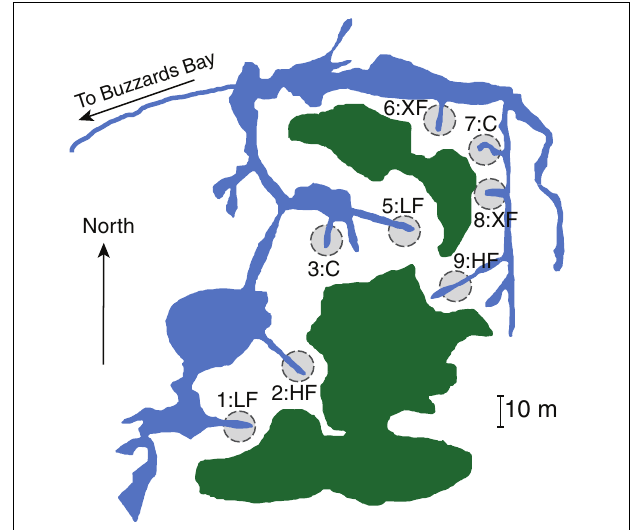
FIGURE 1 | Location and treatment level for each of the marsh plots at Great Sippewissett Marsh, Falmouth, MA, USA. Fertilizers were added in the following doses: Control (C): no fertilizer added, low dose (LF): 0.85g N m − 2 wk − 1 , high dose (HF): 2.52g N m − 2 wk − 1 , and extra high dose